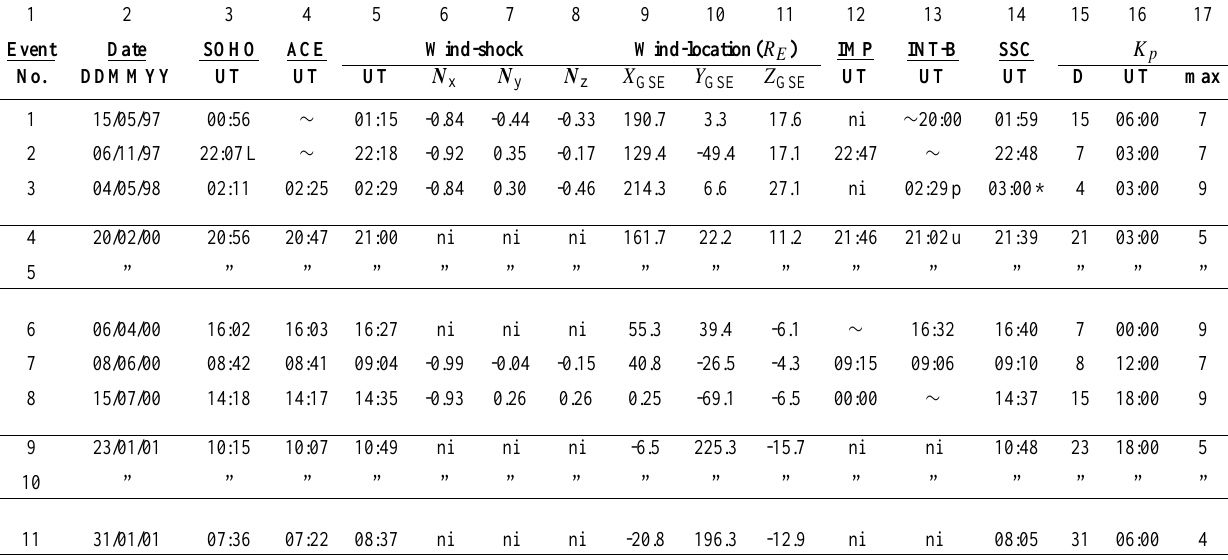
Table 3. Shock arrival times at various spacecraft near the